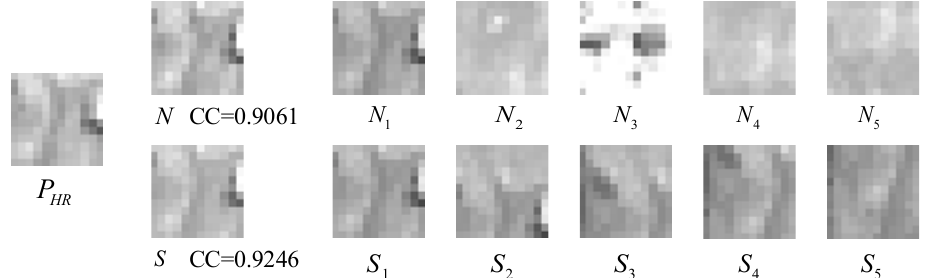
Figure 5. Neighbors found by neighbor embedding (NE) and SWNE. The target HR patches N and S are reconstructed by the corresponding neighbors found by NE and SWNE and then the reconstruction performance is evaluated by correlation coefficient (CC) compared with the reference patch P HR .